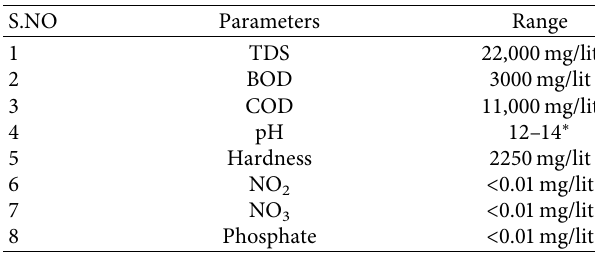
Figure 5: Growth of Gracilaria edulis constructed in Aquaculture. Table 2: Characteristic of lime